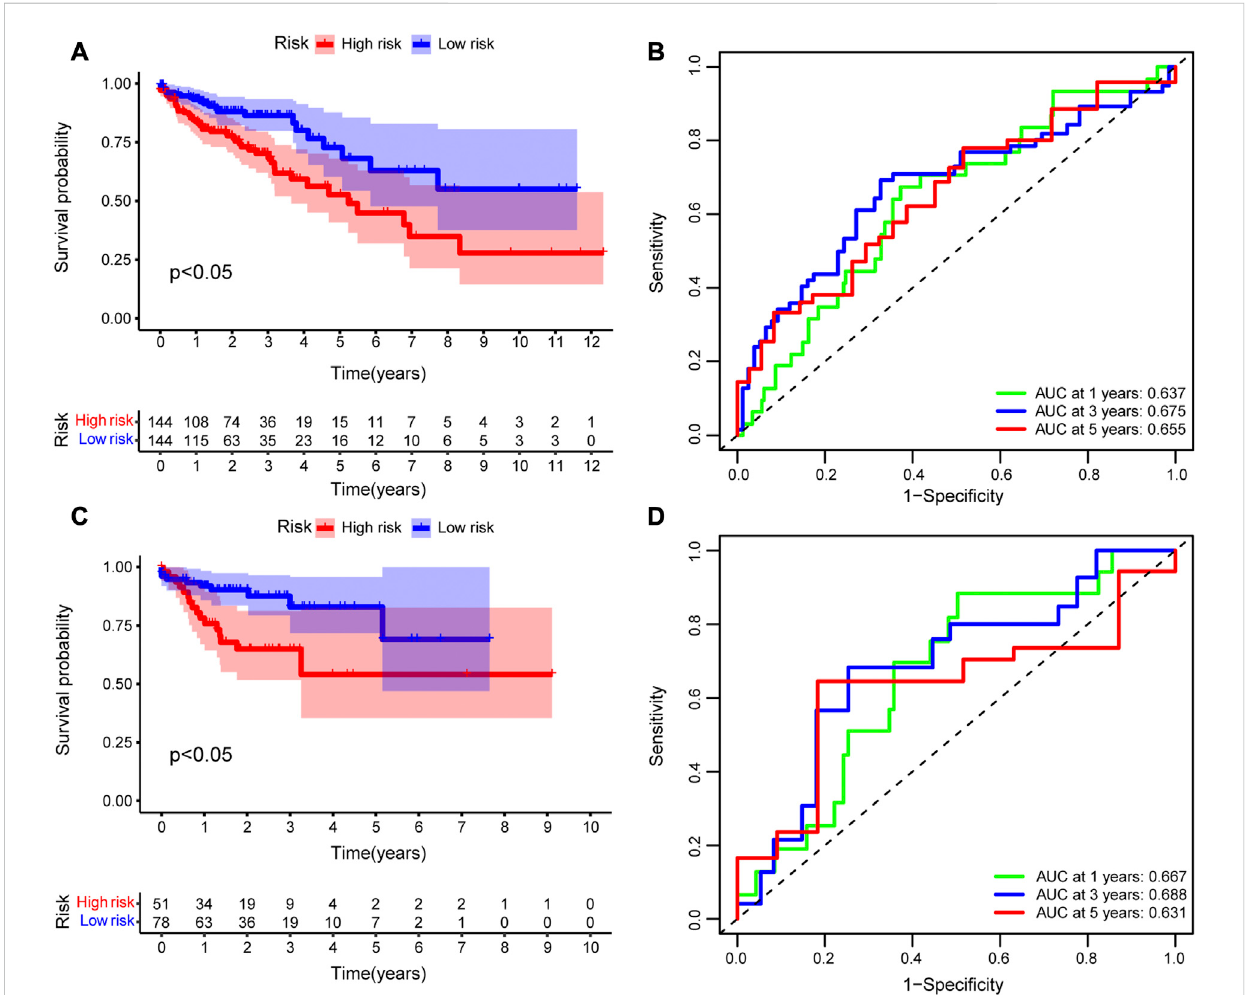
FIGURE 7 Evaluation of the prognostic model. Kaplan – Meier (K – M) survival analysis between high-risk and low-risk groups in the (A) training cohort and (C) validating cohort. Time-dependent receiver operating characteristic (ROC) analysis of 1-, 3-, and 5-year overall survival rates based on risk score of patients with CRC in the (B) training cohort and (D) validating